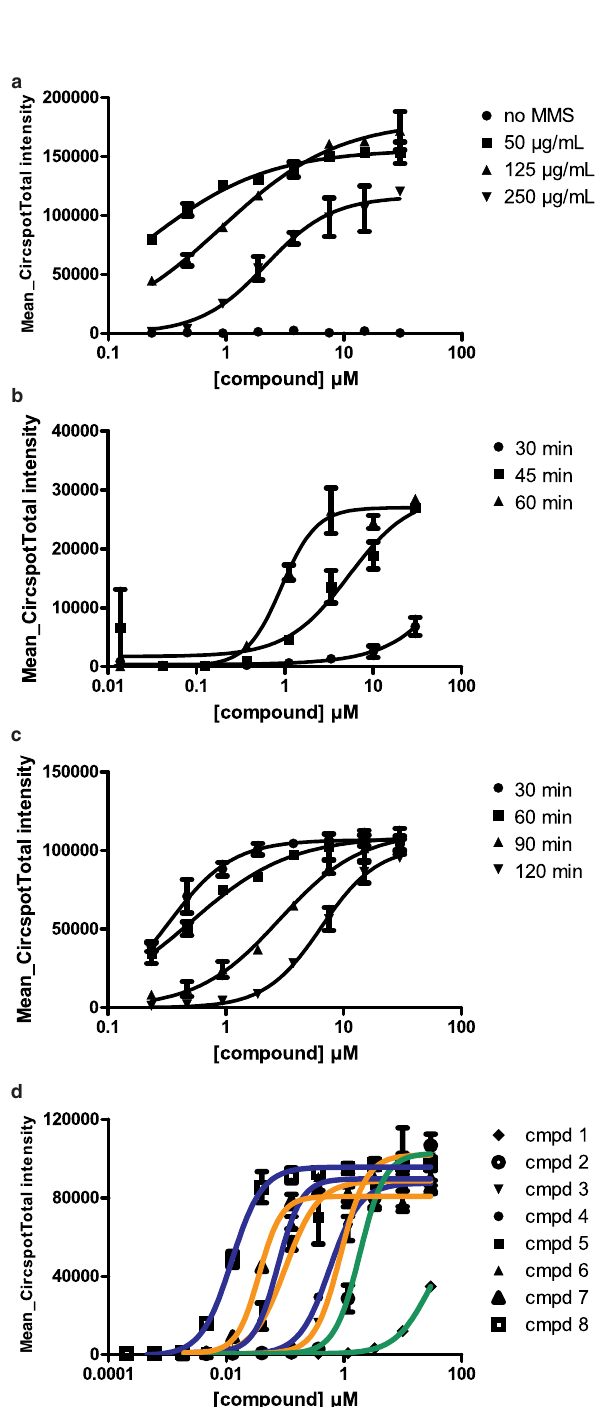
Figure 3. Enhancing PAR chain assay sensitivity. ( a ) Decreasing the concentration of MMS moved the PARG inhibitor IC indicating a greater sensitivity. ( b ) PAR signal response with 25 µg/mL MMS shows that lower doses of MMS only elicit a nuclear PAR response with longer incubation times. ( c ) Increasing the time of incubation with 50 µg/mL MMS shifts the PARG inhibitor IC right decreasing sensitivity. ( d ) A selection of eight PARG inhibitor compounds from a PARG biochemical screen with a range of potencies also shows a range of sensitivities with this PAR chain assay. Different chemical cores of the compounds are shown (green, orange, blue). The compounds are ordered by sensitivity (cmpd 1, least sensitive; cmpd 8, most sensitive). Compound 4 is